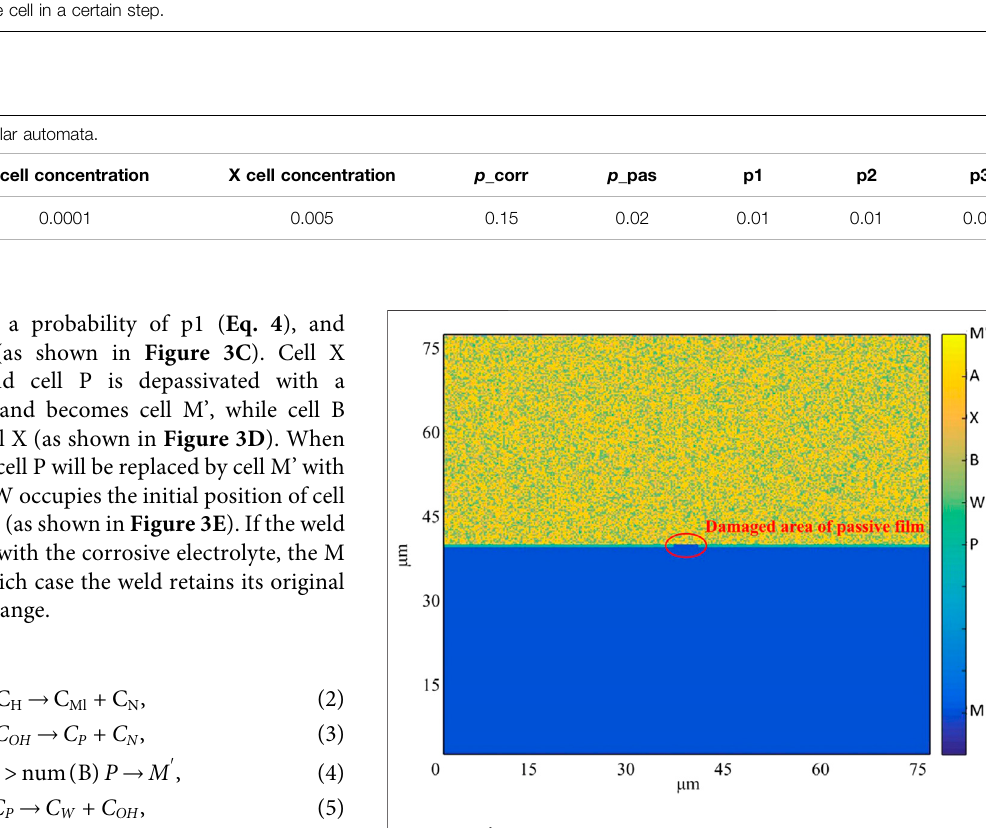
FIGURE 4 | Initial state of cellular